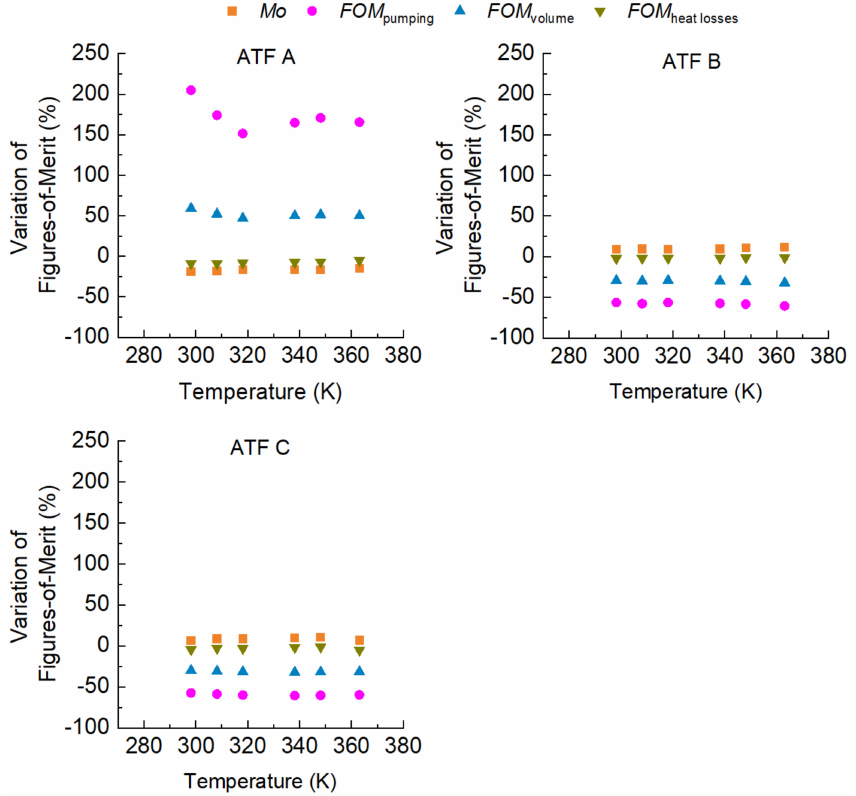
Figure 8. Sensitivity to temperature of the variation of figures-of-merit with